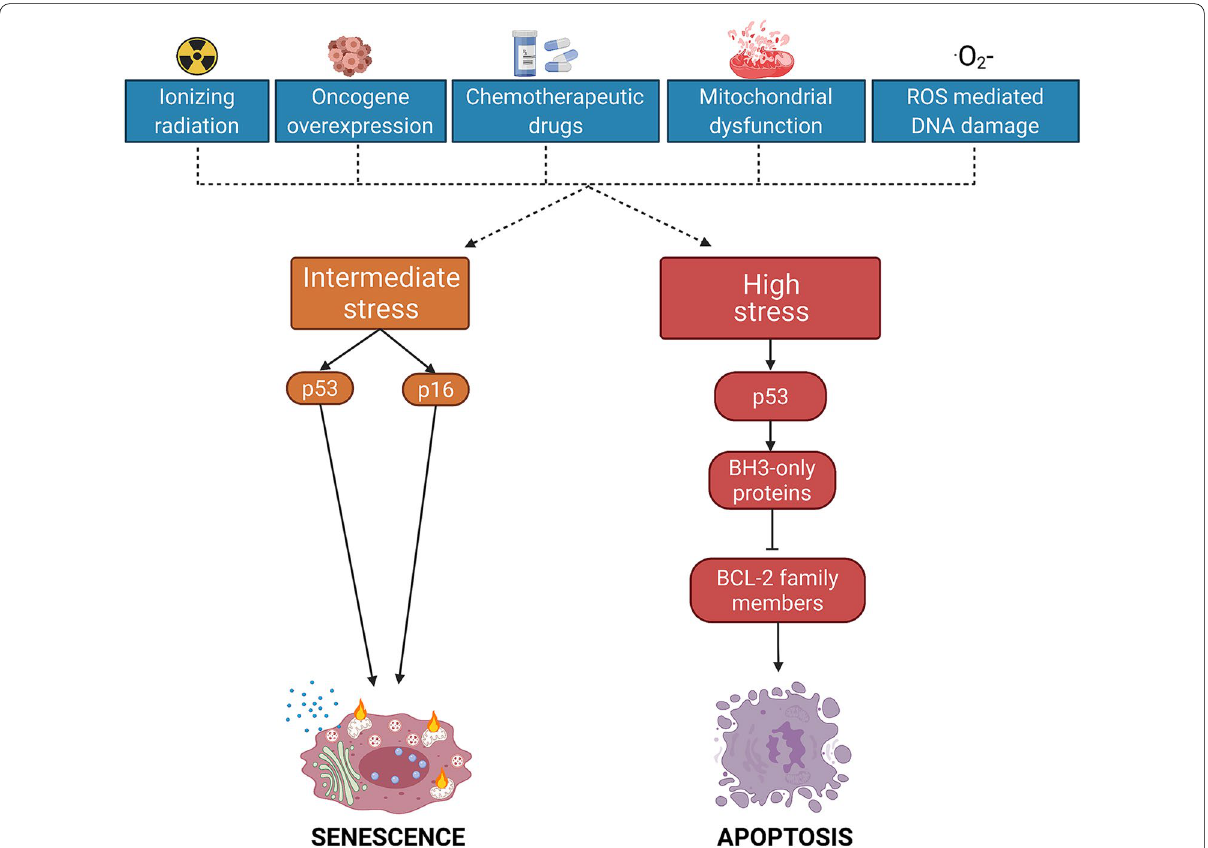
Fig. 2 Difference between senescence and apoptosis. Intermediate stress can lead to senescence via p53 and p16 pathway, resulting in persisting cell dysfunction. High cellular stress can induce apoptosis through upregulation of p53, resulting to cell death and elimination. High level of p53 contributes to the induction of BH3‑only proteins (BIM, PUMA, NOXA) that inhibits pro‑survival BCL‑2 family members (BCL‑XL, MCL‑1, BCL